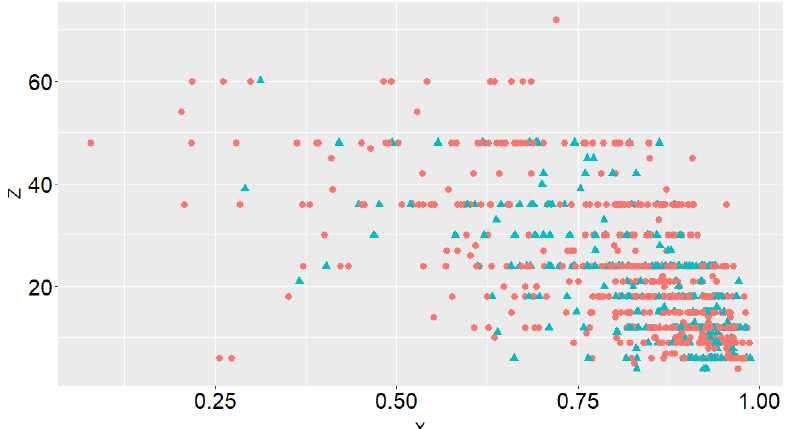
Figure 11. Scatter plot of credit scoring and duration of the credit in the censored group (red circles) and the uncensored group (blue triangles) of the German credit